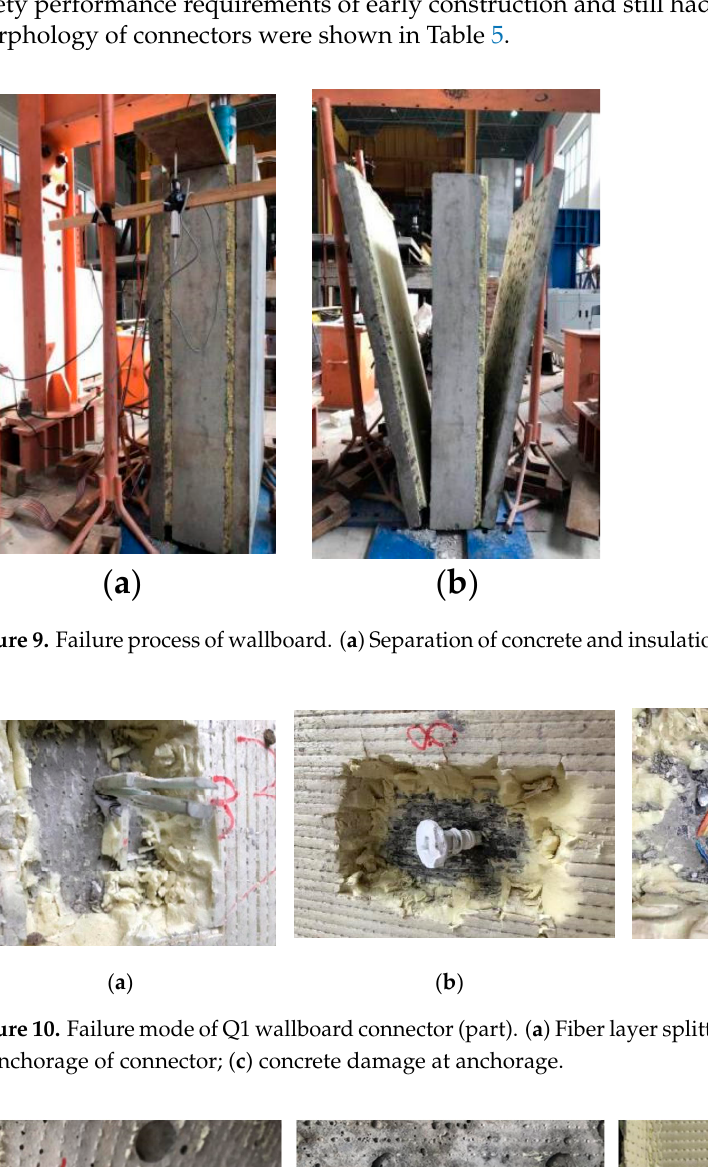
Figure 9. Failure process of wallboard. ( a ) Separation of concrete and insulation; ( b ) final failure result.